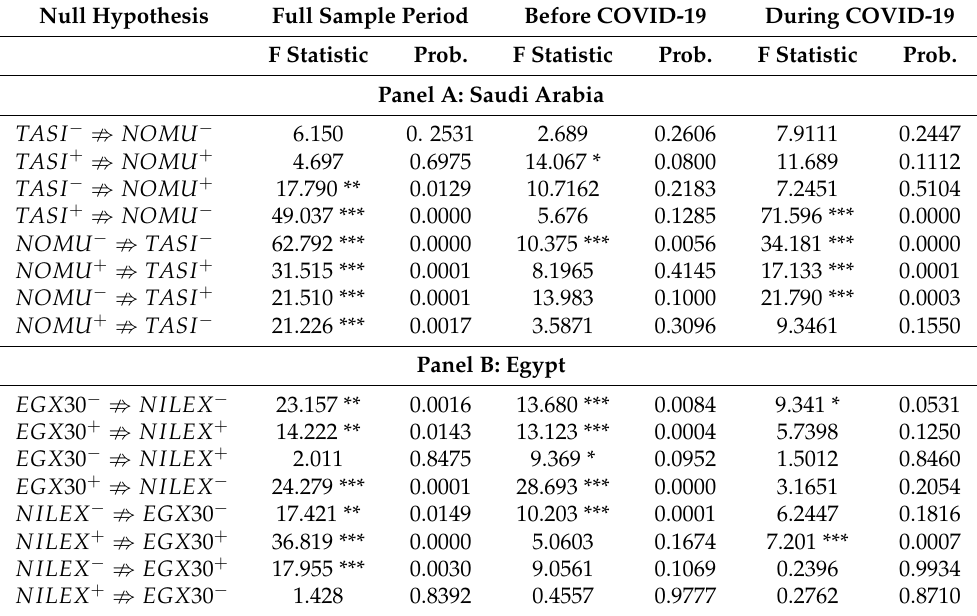
Table 2. Asymmetric causality between the main and SME stock markets. Null Hypothesis Full Sample Period Before